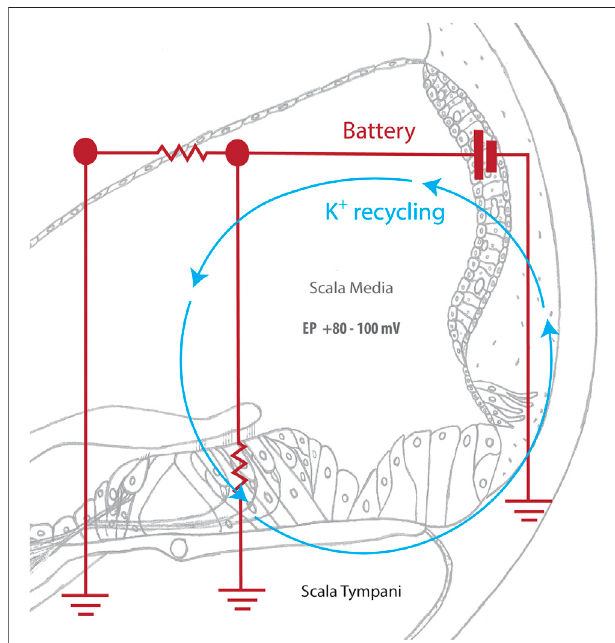
FIGURE 2 | The cochlear battery facilitates sound detection. Sound waves de fl ect hair cell stereocilia, mechanically opening K+ channels and allowing potassium ions (K+) from the scala media to enter the hair cell. The subsequent depolarizationofthehaircellactivatesvoltage-gatedcalciumchannels,which triggersacalciumin fl uxthatcausesneurotransmittertobereleased atthebaseof the hair cell. Neurotransmitter then diffuses into the nerve terminal and causes an actionpotentialtobecreatedinthespiralganglion.Thissignalisthentransmittedto thebrainforauditoryprocessing.TheSVactivelyreturnspotassiumionsthatwere used during this process to the scala media, maintaining the endocochlear potential and allowing for continuous sound detection.